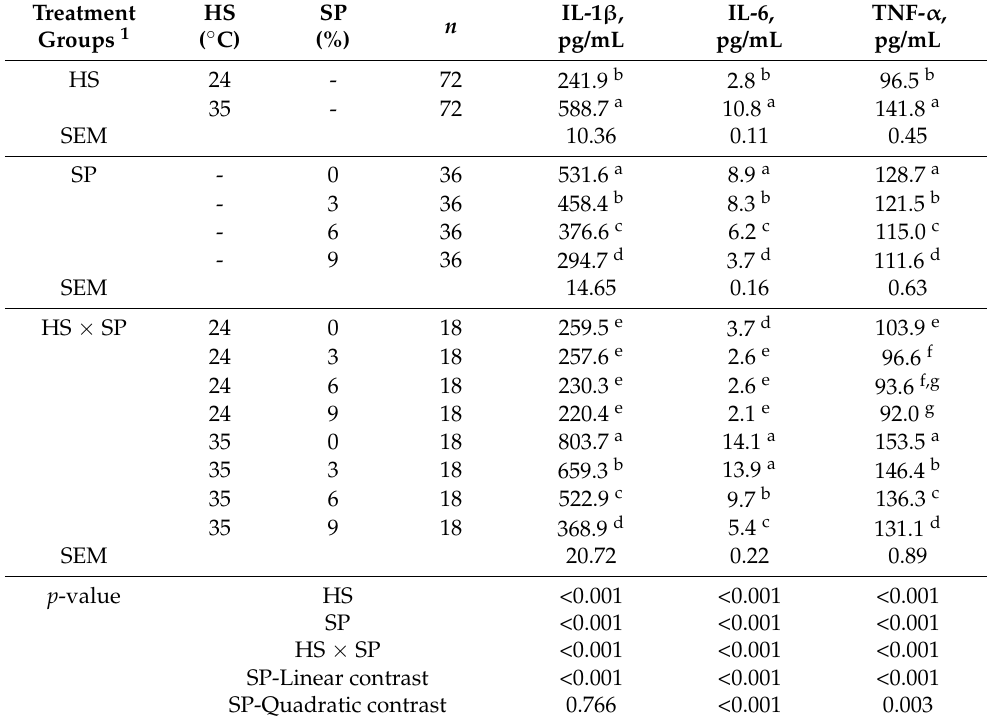
Table 5. Effect of dietary Spirulina platensisis (SP) supplementation on the inflammatory cytokines of laying hens exposed to cyclic heat stress